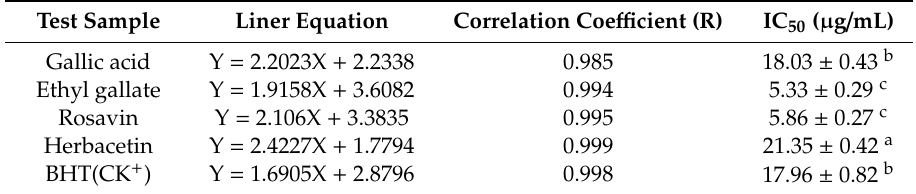
scavenging Table 6. The IC 50 values of the four identified compounds from R. crenulata in DPPH radical scavenging assay.